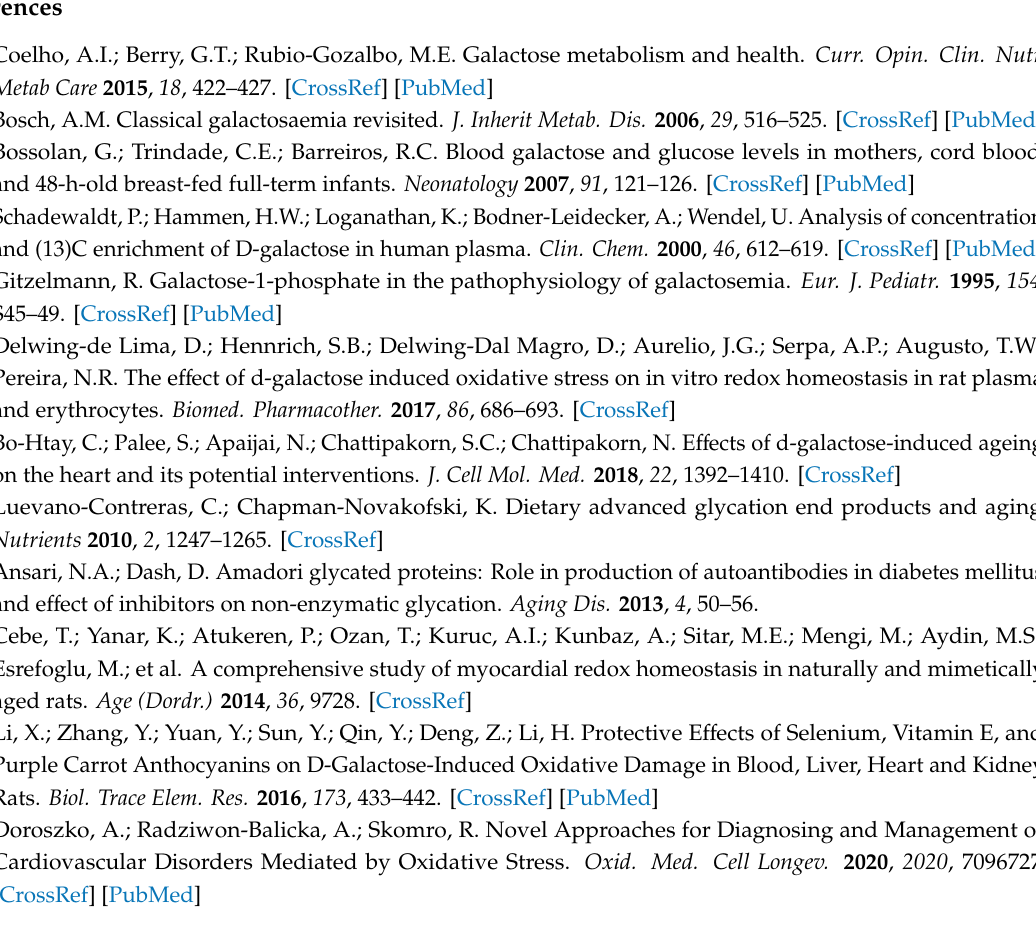
Figure S1: Estimation of GSH / GSSG ratio measured in untreated (control) and d -Gal treated erythrocytes at di ff erent concentrations (0.1 and 10 mM) with or without 50 mM 3-AT incubated for 24 h. ns not significant vs control; *** p < 0.001 significant vs control; §§§ p < 0.001 vs 0.1 mM d -Gal; as determined by one way ANOVA followed by Bonferroni’s post hoc test ( n = 3